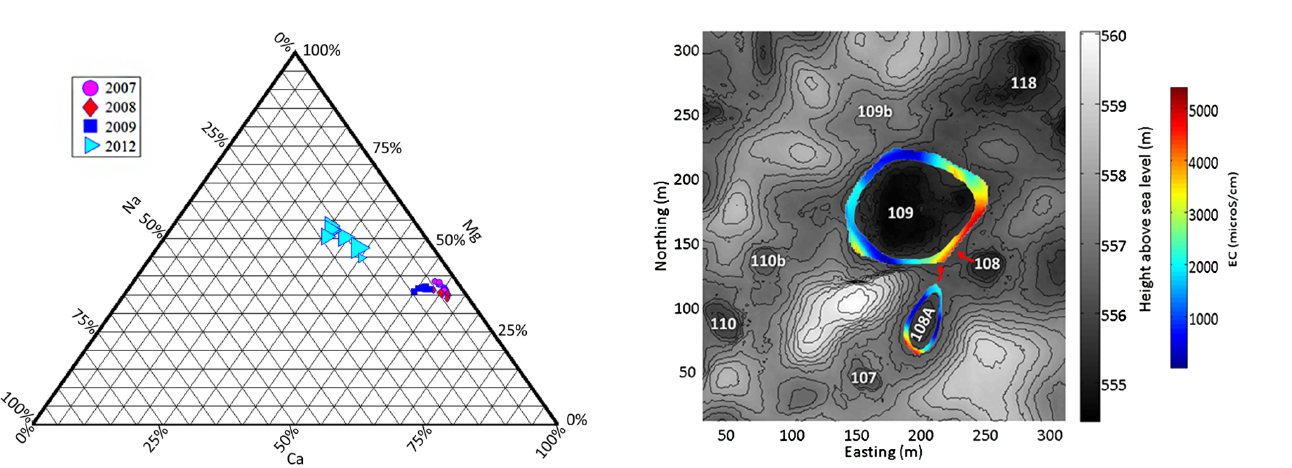
Fig. 6. Major cations molar fraction in pond 109 for the years 2007– 2009 and 2012. Marker size is proportional to the pond EC.